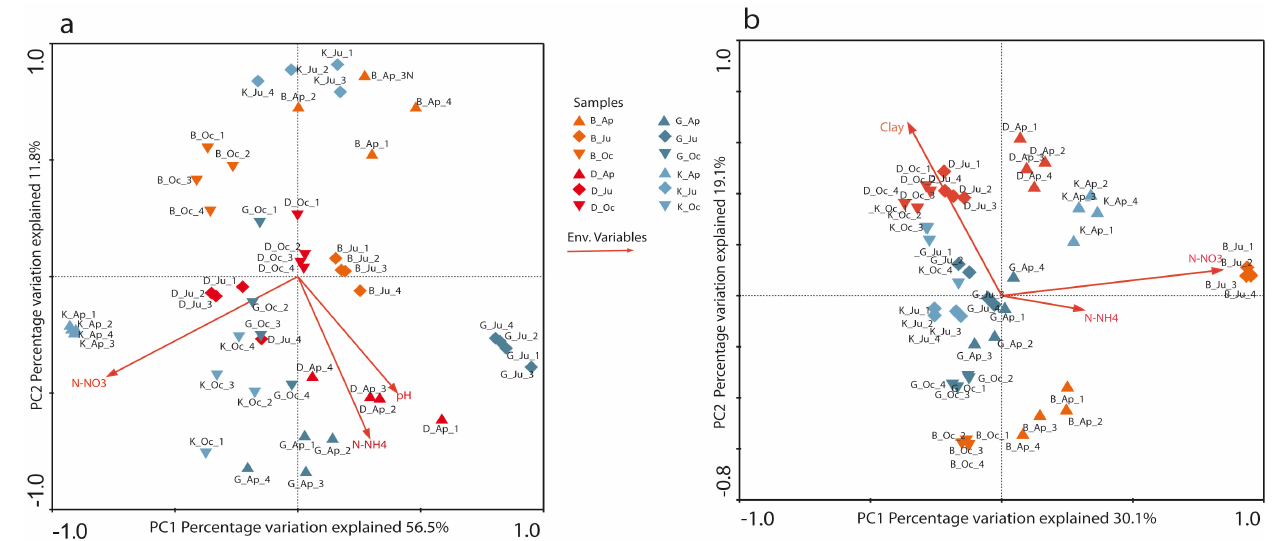
Figure 2. Changes in the structure of total bacterial and N-fixing communities from DGGE fingerprints across different soils and sampling